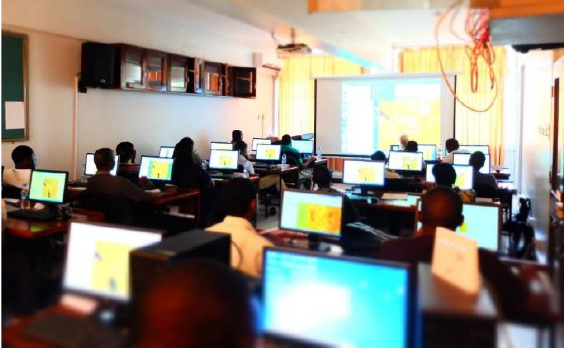
Figure 2. Collaborative data collection at the Mapathon